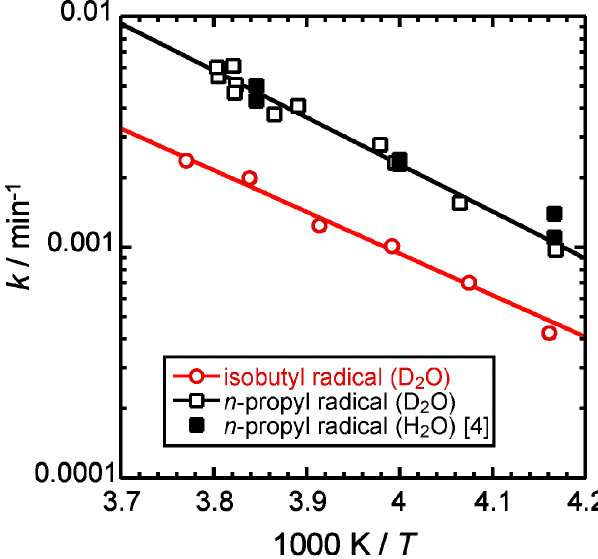
Figure 5. Arrhenius plots of the decreasing rates for isobutyl and n -propyl radicals in